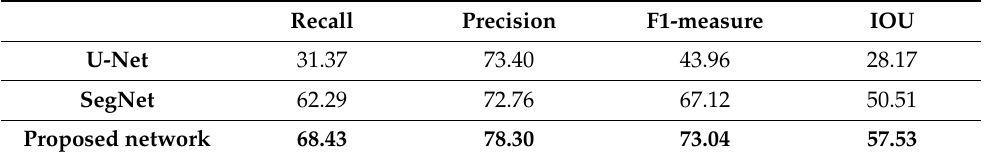
Table 4. Evaluation statistics (%) in landslide detection from Nepal study area.